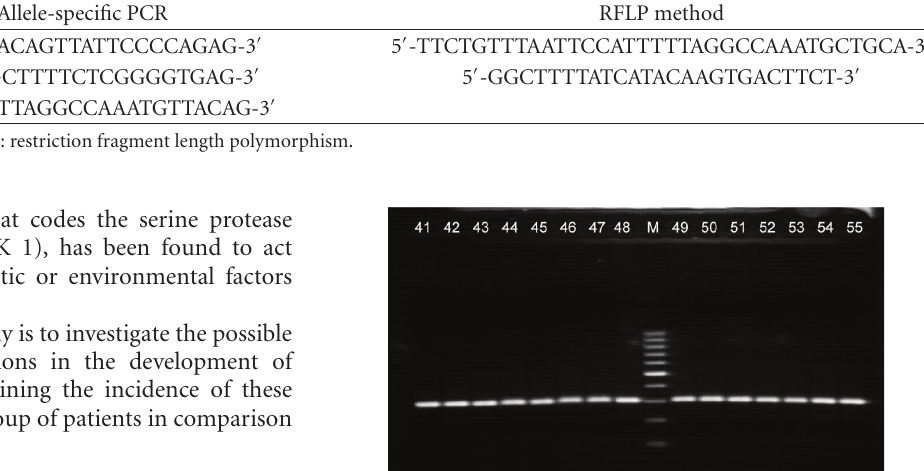
Figure 1: Allele-specific PCR analysis of the N34S mutation on exon 3 of the SPINK gene. The wild-type SPINK band is located at 285 bp. If the N34S mutation is present, a second band at 190 bp appears. The lanes 41 to 55represent patients without the N34S mutation (normal). The lane marked with M represents the 100 bp DNA Ladder (Fermentas Life Sciences,